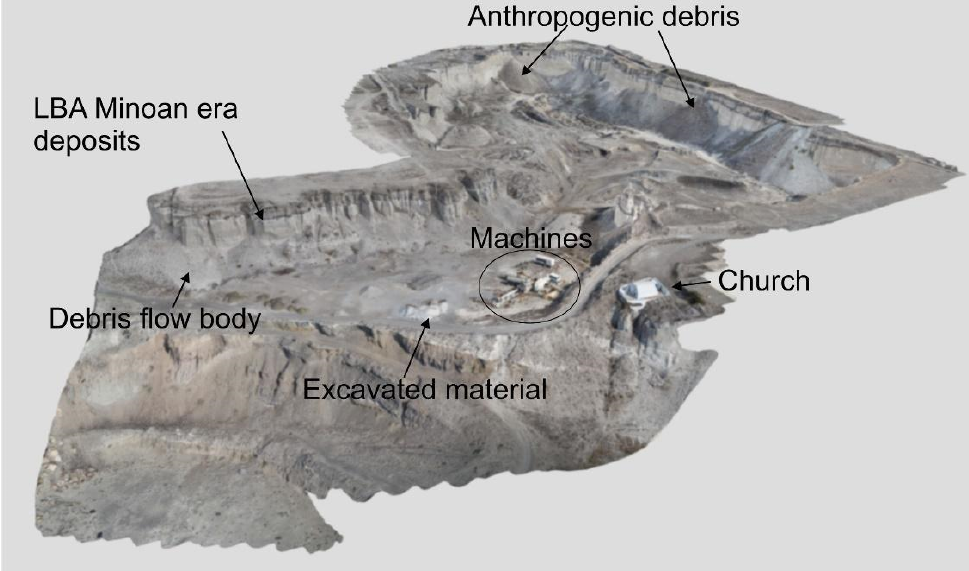
Figure 2. 3D eastern view of the Virtual Geosite of the Metaxa Mine. See the white church on the right hand side for scale.